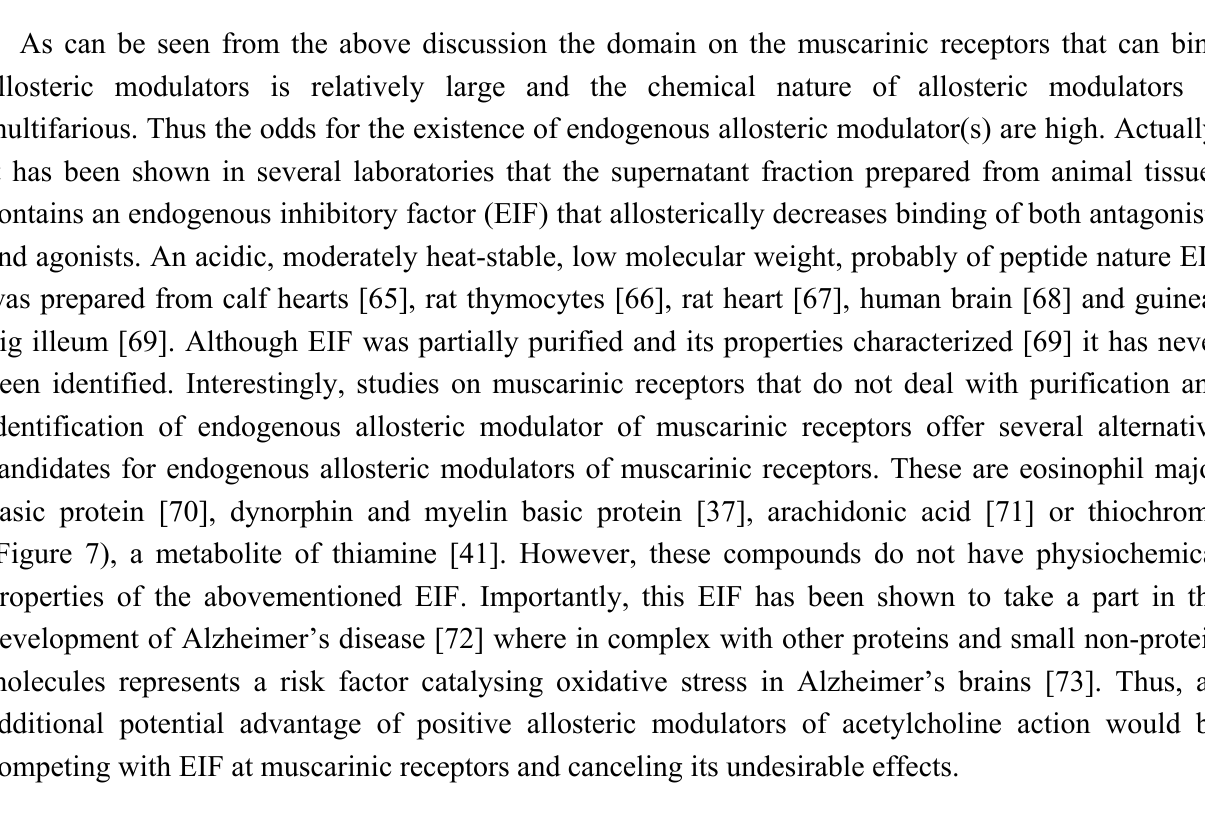
Figure 7. Structure of